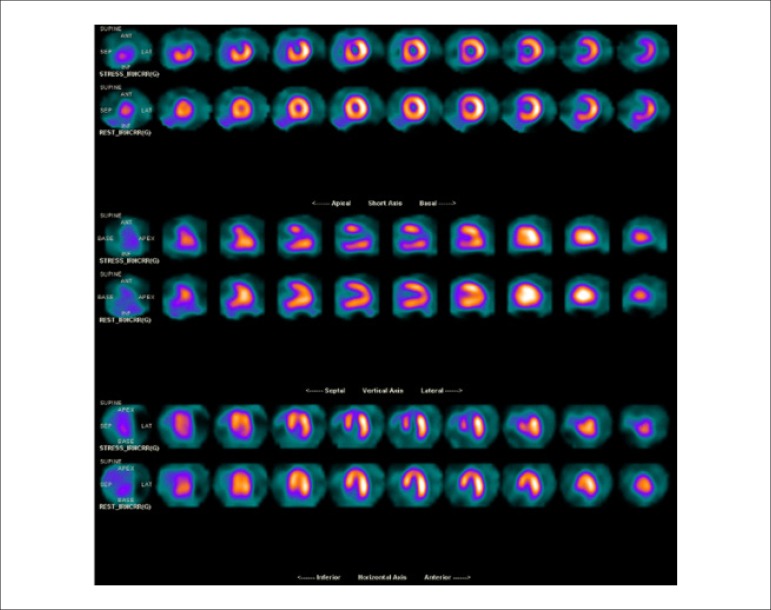
Case 5 - Myocardial perfusion scintigraphy demonstrating significant ischemia in the territory of the anterior descending artery. Images acquired with dedicated cardiac equipment (gamma camera), equipped with conventional sodium iodide crystals.